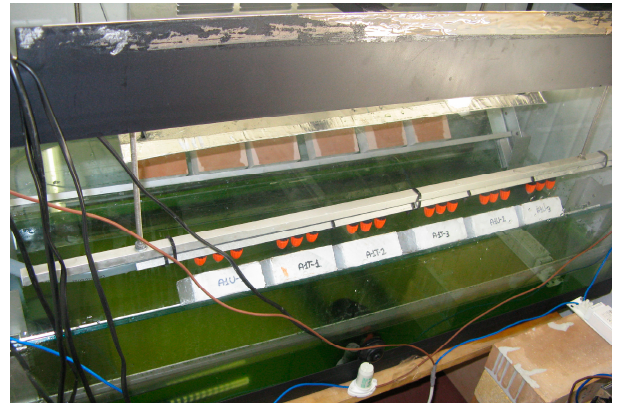
Figure 1. Test apparatus for accelerated biofouling test.